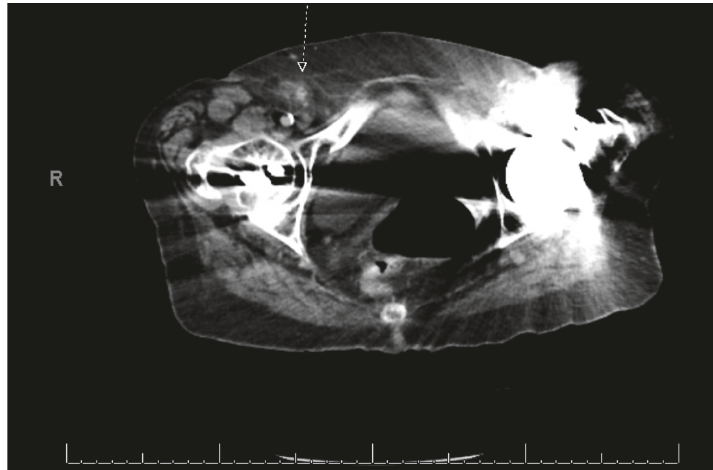
Figure 1: CT abdomen/pelvis image of Amyand’s hernia is referenced by arrow.